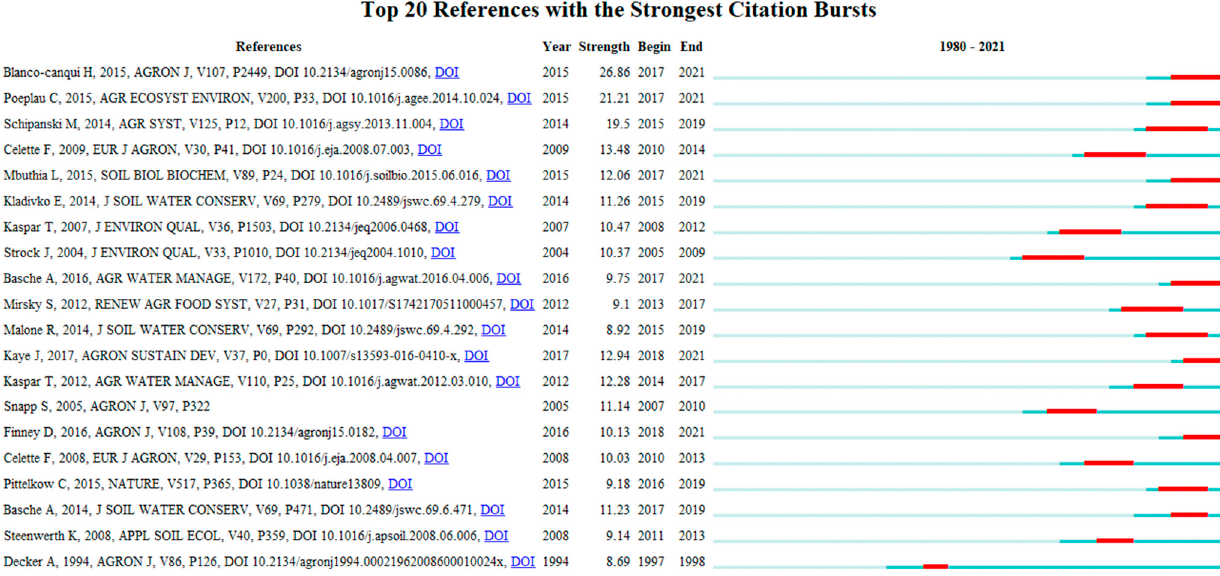
Figure 4. Top 20 References with the Strongest Citation